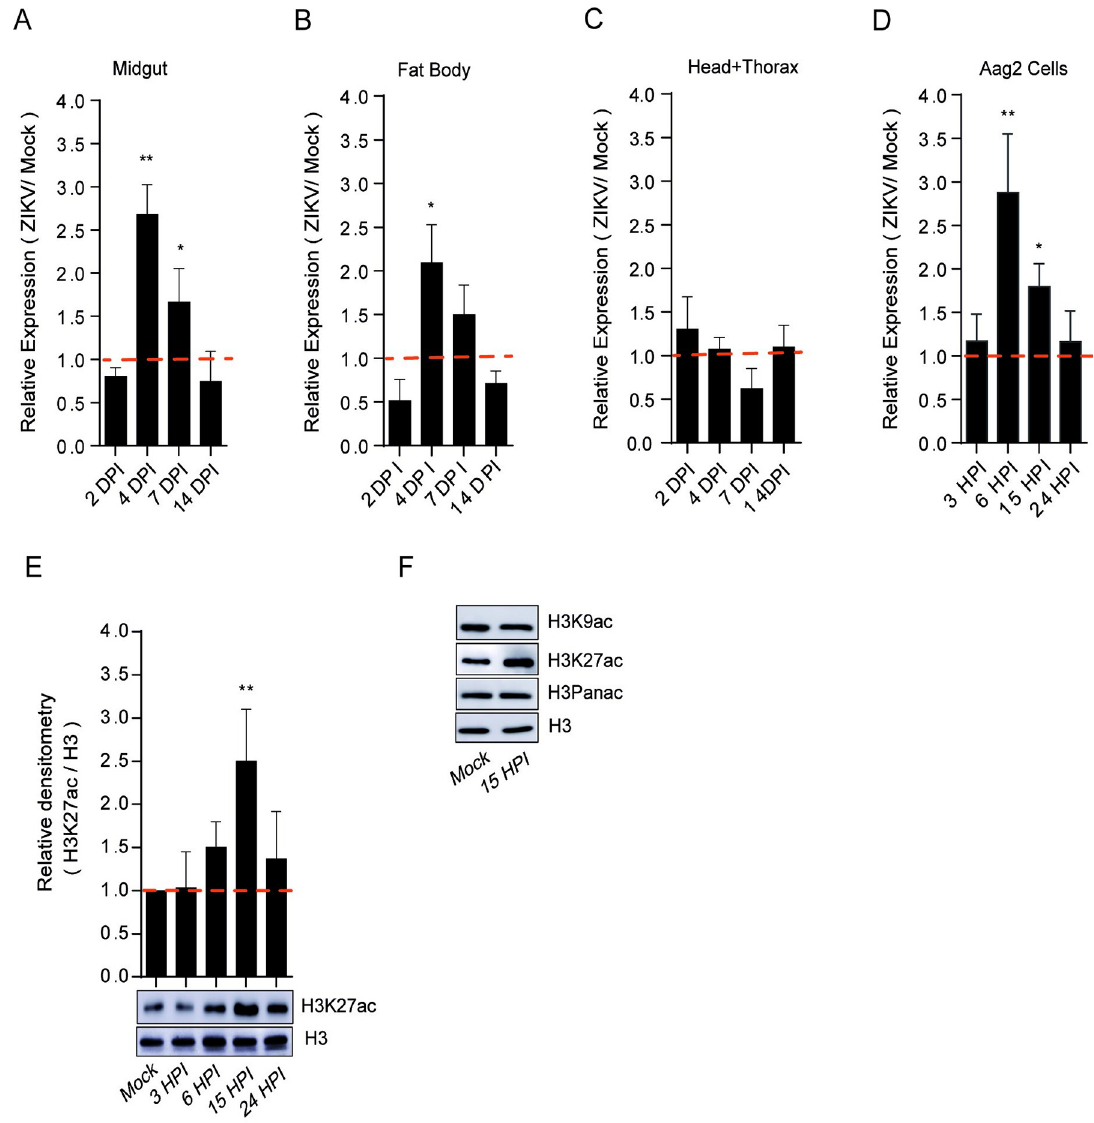
Fig 2. ZIKV infection modulates the expression and activity of AaCBP. Aag2 cells as well as mosquitoes were infected with ZIKV at a MOI of 2.0, and 60 PFUs, respectively. Mosquito infections were performed by intrathoracic injections. The expression of AaCBP in mosquitoes (A-C) or Aag2 cells (D) was measured by qRT-PCR on the indicated tissues and days post infection. E and F. Western blot of total protein extract from Aag2 cells infected with ZIKV virus, or mock-infected at different time points. Monoclonal antibodies against H3K9ac, H3K27ac, H3 panacetylated (Panac), or H3 (as a loading control) were used. The intensity of the bands was quantified by densitometry analysis plotted as a graph using ImageJ (NIH Software). Western blotting was performed on 3 independent biological replicates and one representative is shown here. Error bars indicate the standard error of the mean; statistical analyses were performed by Student’s t test. � , p < 0.05; �� , p < 0.01. infections showed a much higher mortality rate than all other groups (Fig 3B, orange line). These results indicate that even a partial deletion of AaCBP is enough to disrupt the homeosta- sis of the mosquito (Fig 3B blue line), and when virus infection occurs, the lack of AaCBP becomes enormously detrimental. To correlate the lack of AaCBP and mortality, with an increase in viral loads, we deter- mined viral titers over time in the midguts and fat bodies (Fig 3C and 3D, respectively). We